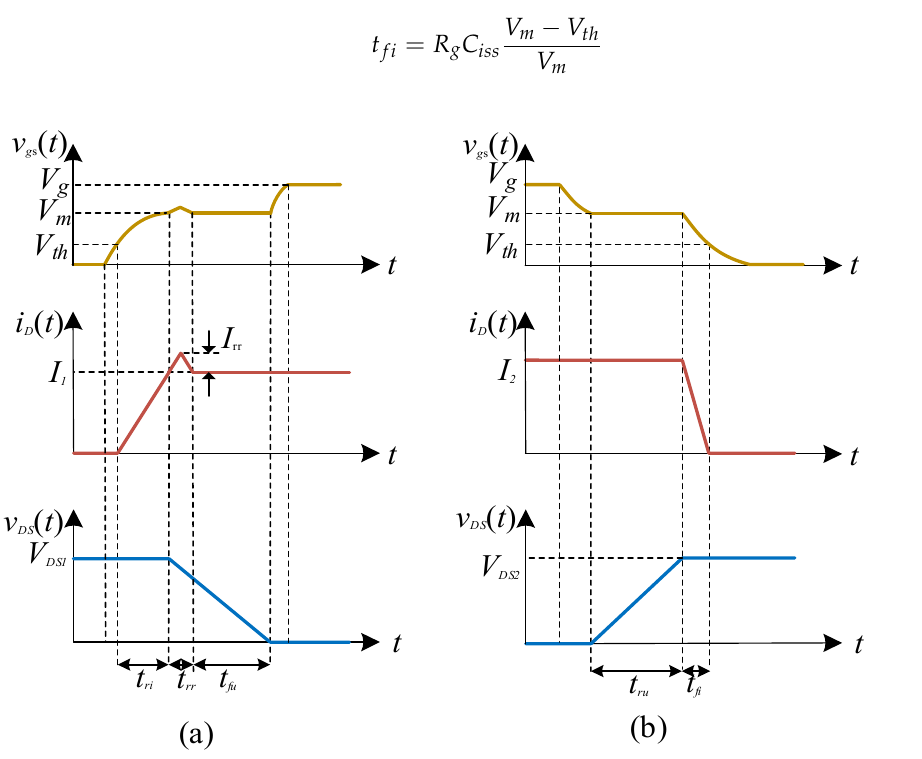
Figure 12. Waveforms when MOSFETs turned on and off: ( a ) the turning on transient; ( b ) the turning off transient. Analysis of Communication between the Charging and Discharging States When the CSI transited between the charging and discharging states, S 1 – S 4 stayed ON and there was no power loss consumed from S 1 –S 4 during this process. The current communication was between the freewheel diode and S 5 , as shown in Figure 13.